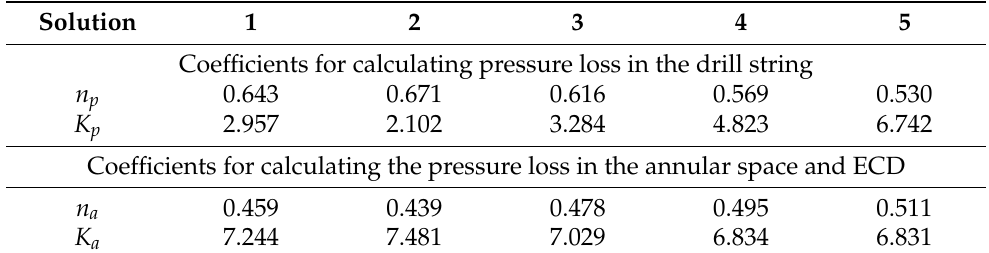
Table 5. Calculated coefficients of the studied drilling fluids.